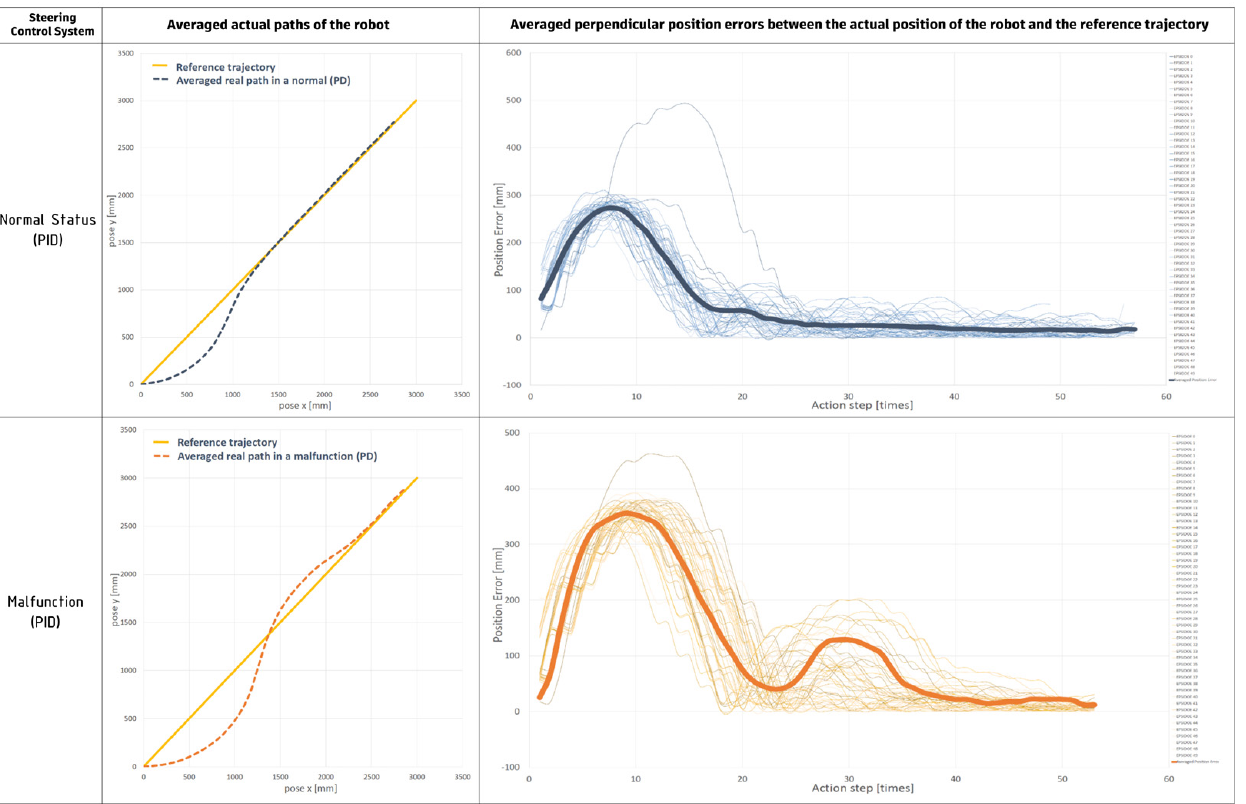
Figure 24. Averaged actual paths and perpendicular position error from the optimum reference trajectory obtained through repeated experiments in motion planning with the PID controller.